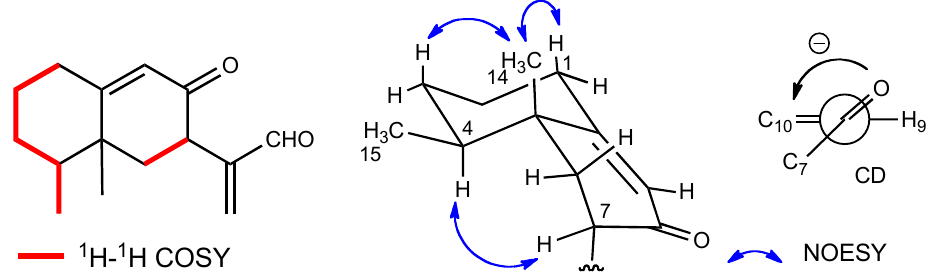
Figure 4. Selected 2D correlations and the sign of the CD for compound 2